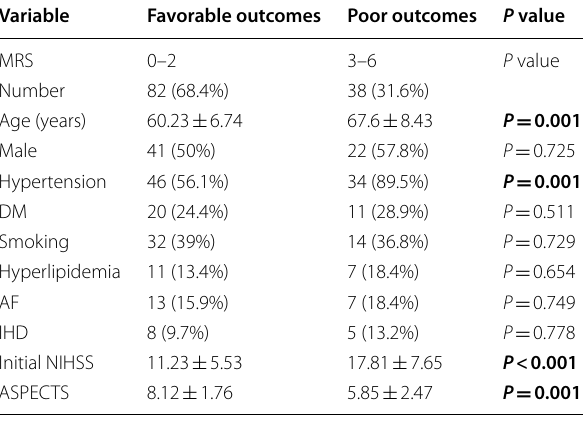
Table 5 Multivariate logistic regression analysis for